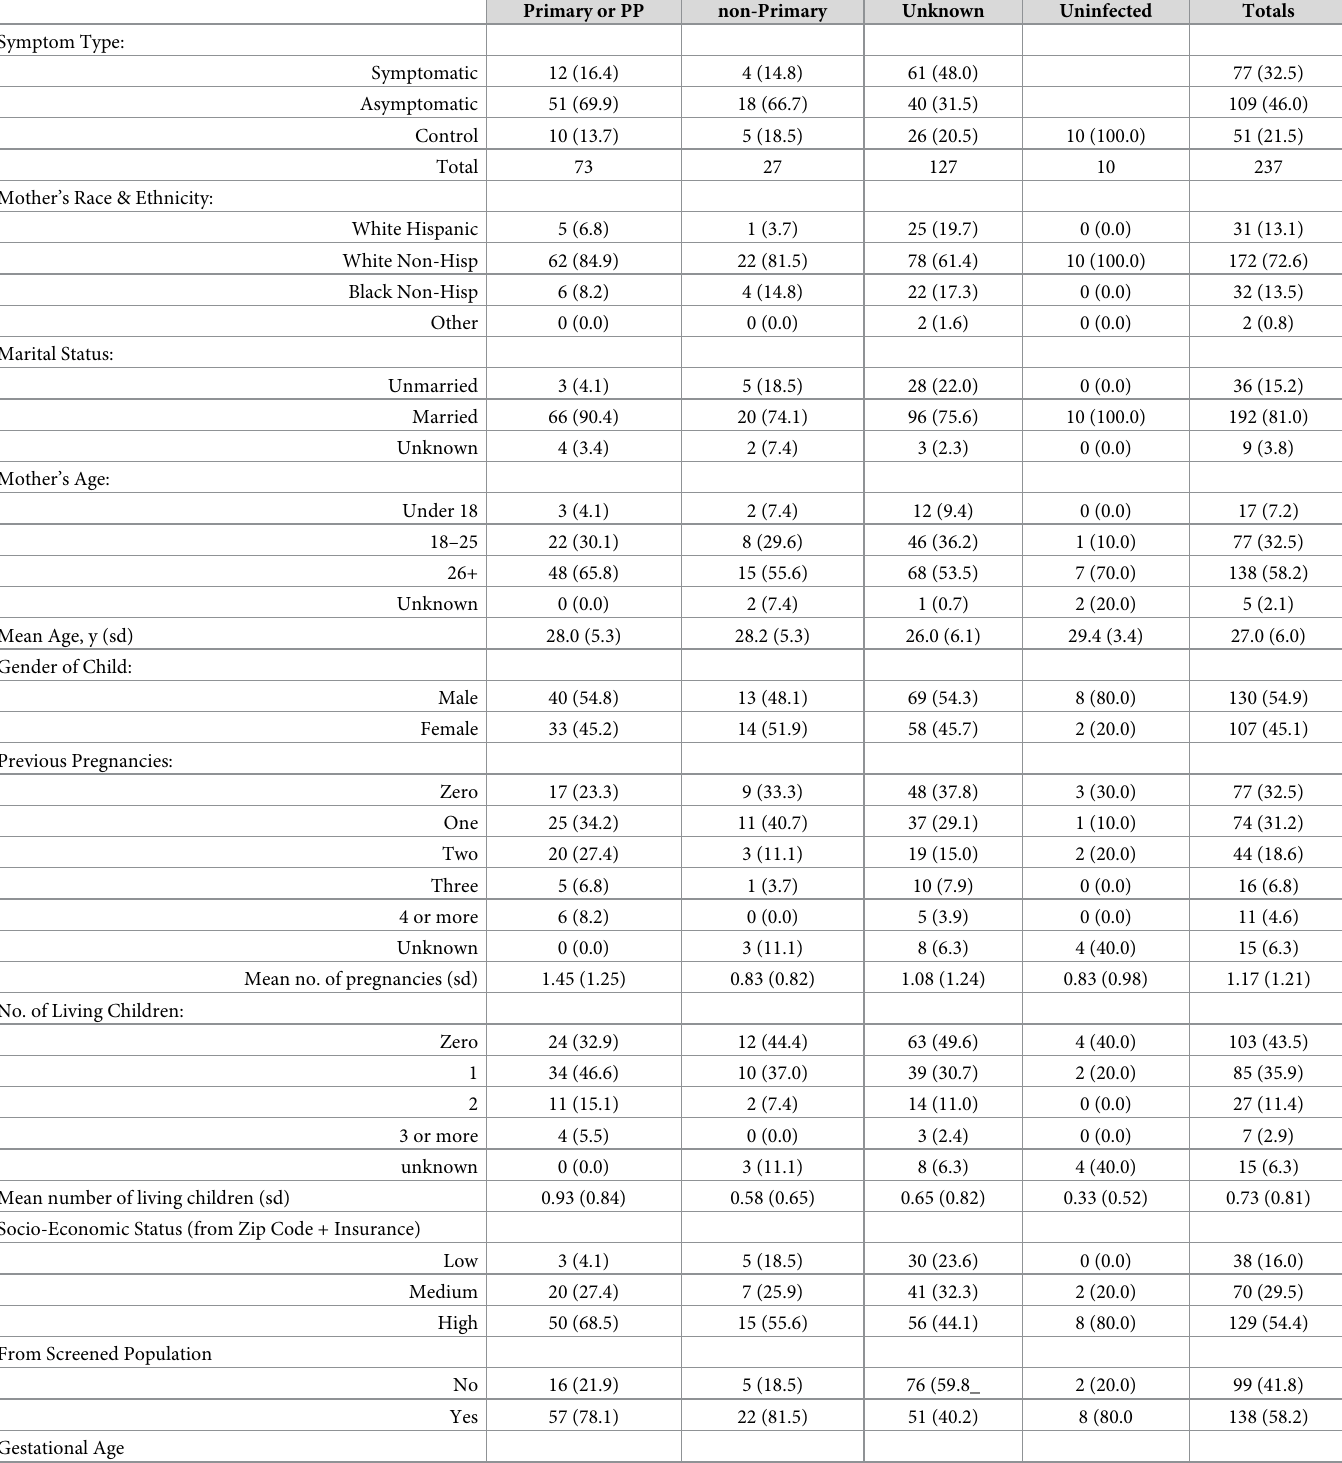
Table 1. Demographic birth characteristics of mothers of infants enrolled in the Houston congenital CMV longitudinal study, by type of maternal CMV infection during pregnancy. Primary or